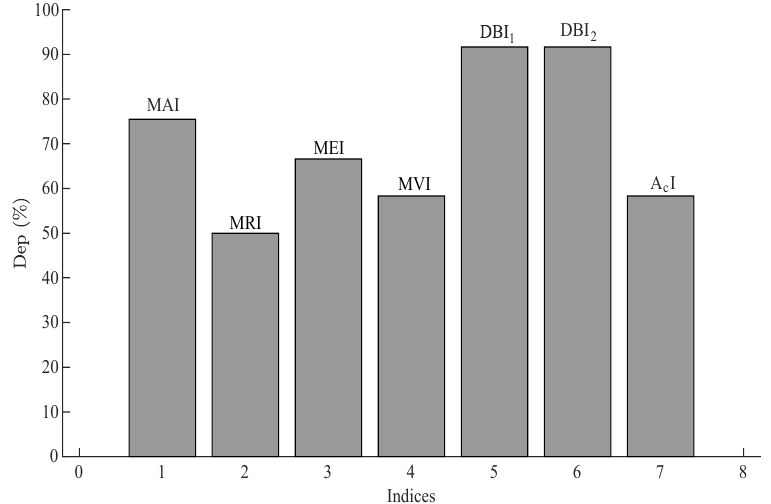
Figure 18. Dependability of the indices used in the proposed